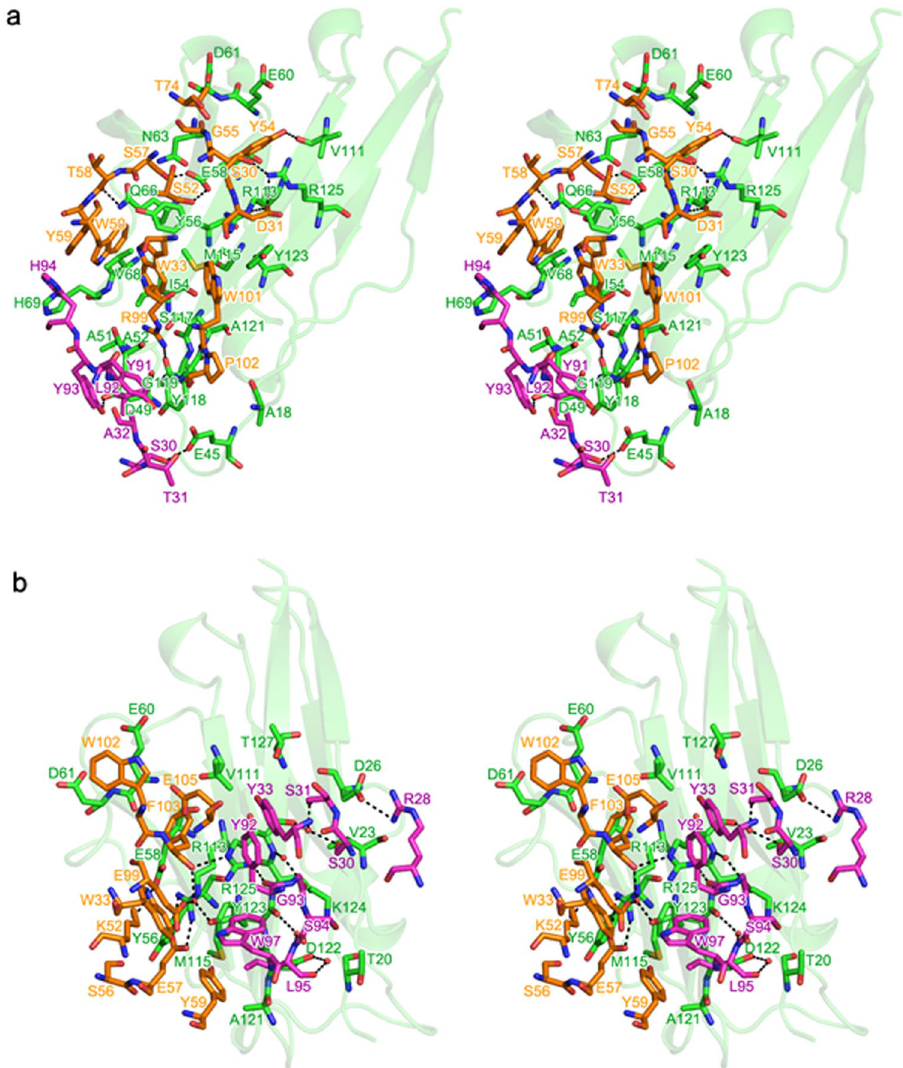
Figure 3. Interactions of atezolizumab and durvalumab with PD-L1. ( a ) Stereoview of the detailed PD-L1/ atezolizumab Fab fragment interface. ( b ) Stereoview of the detailed PD-L1/durvalumab Fab fragment interface. In ( a , b ) the carbon atoms from PD-L1 and the antibody heavy and light chains are colored green, orange, and purple, respectively. Hydrogen bonds and salt bridges are indicated with dashed